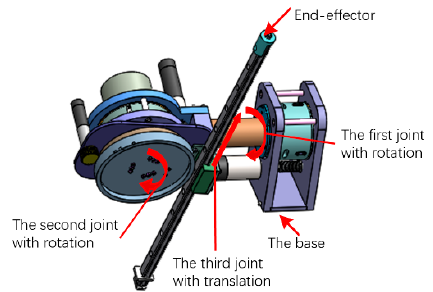
Figure 1. The proposed compliant robot with three DoFs.